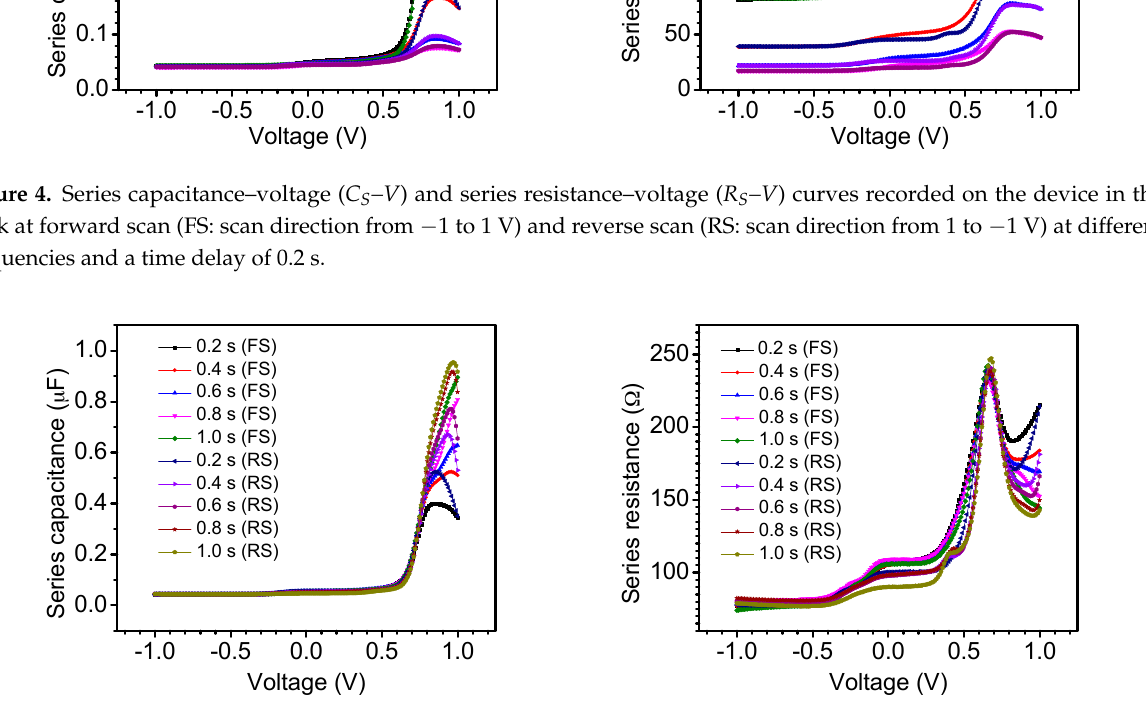
Figure 5. Series capacitance–voltage ( C S –V ) and series resistance–voltage ( R S –V ) curves recorded on the device in the dark at forward scan (FS: scan direction from − 1 to 1 V) and reverse scan (RS: scan direction from 1 to − 1 V) at different time delays and a frequency of 5 kHz.